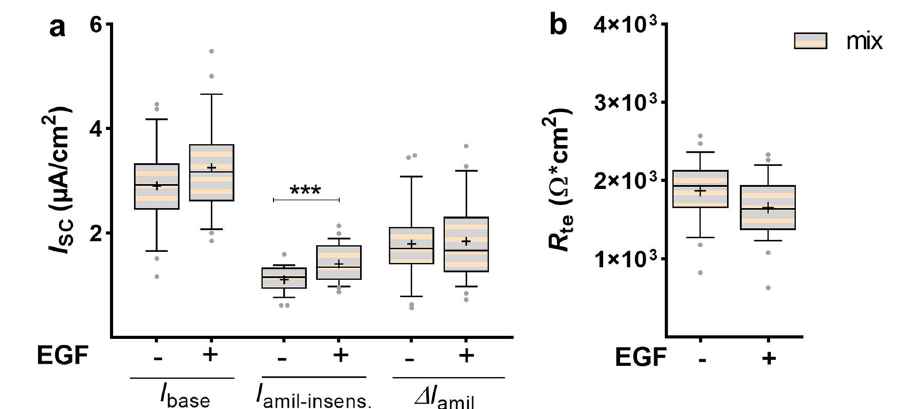
Figure 3. Persistence of EGFs’ effect. FDLE cells (mixed sexes) were cultured in SF-Med and stimulated with or without EGF for 24 h, followed by a medium exchange to SF-Med lacking EGF in both groups and culture for another 24 h. Data are displayed as box and whiskers with the 10–90 percentile, mean (+) and median (horizontal line). ( a ) The reducing effect of EGF on I base and Δ I amil did not persist after 24 h culture in SF-Med, while the increasing effect on I amil-insens was retained in mixed FDLE cells (n = 26/27; *** p < 0.001 by t -test). ( b ) Furthermore, the stimulating effect of EGF on R te was lost after 24 h in